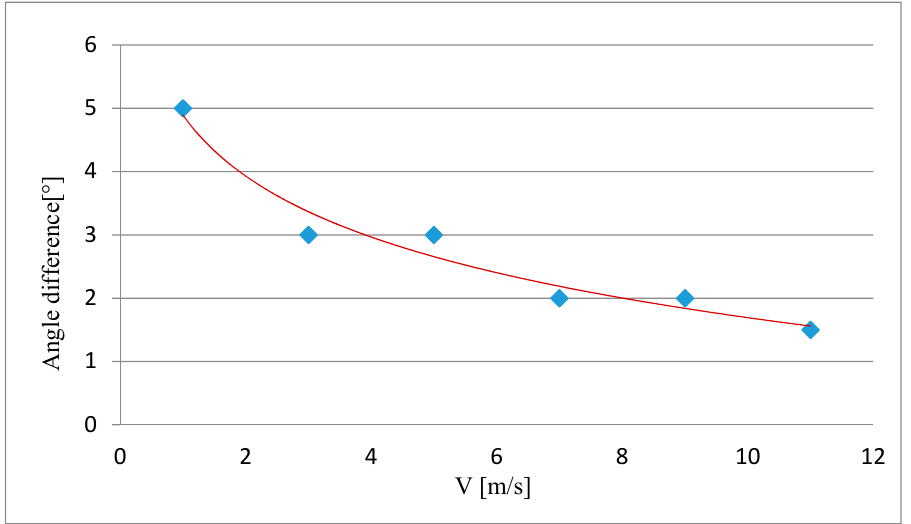
Figure 12. Chart of the relation between the difference in the established and actual camera tilt angles and the UAV speed.